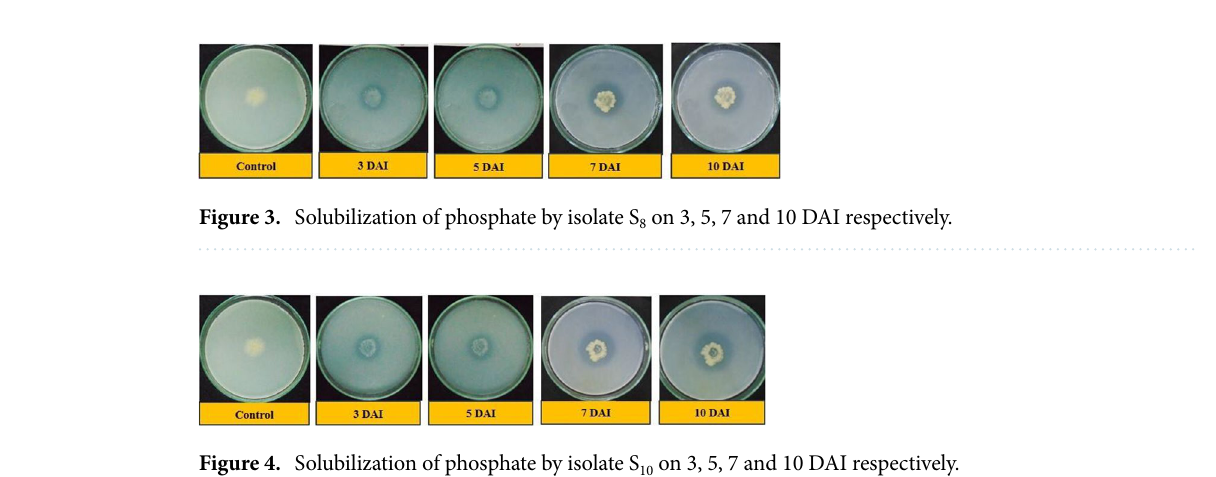
Figure 4. Solubilization of phosphate by isolate S 10 on 3, 5, 7 and 10 DAI